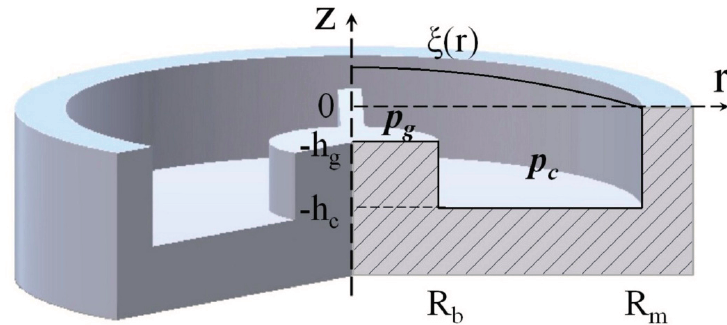
Figure 1. Schematic diagram of acoustic